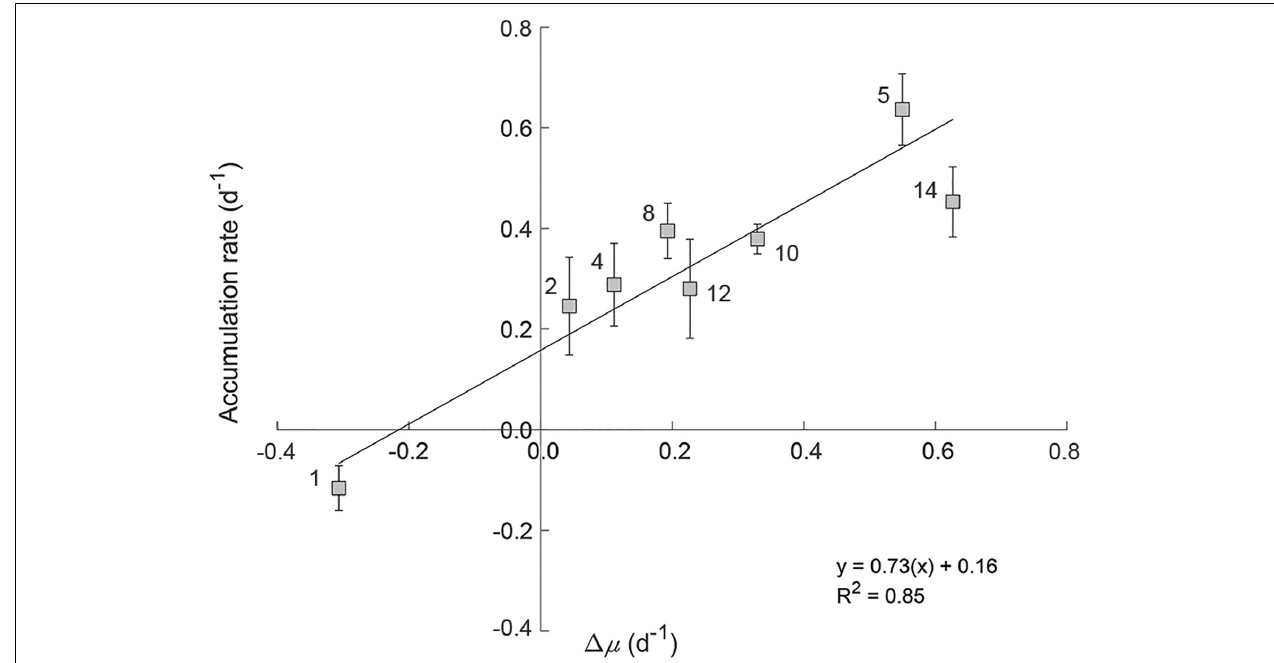
FIGURE 7 | The relationship between the rate of change in division rate ( (cid:49) µ ) and measured accumulation rates of the phytoplankton communities within experimental incubations. Station numbers are indicated on plot. Error bars represent standard